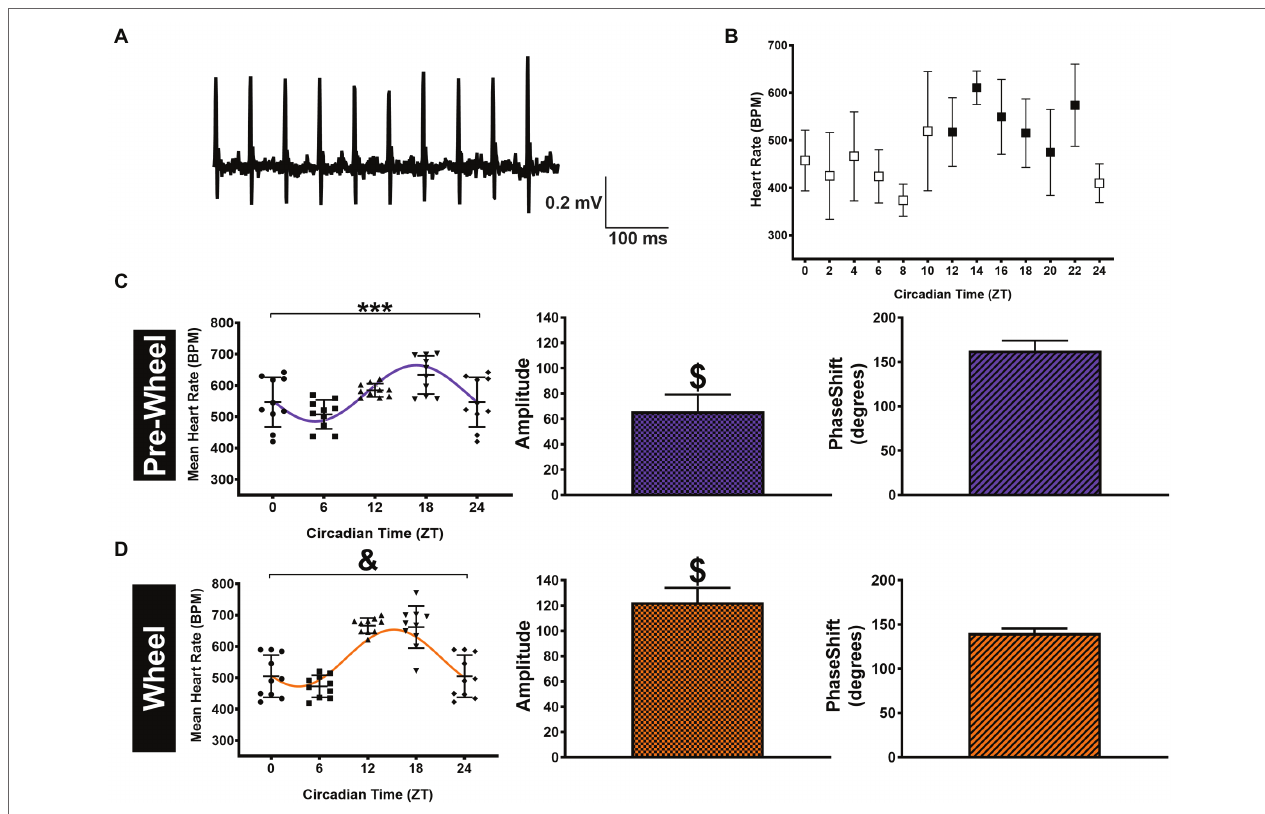
FIGURE 2 | HR measurements and analyses in telemetrized conscious mice. (A) Representative sample telemetry ECG tracings recorded from a sedentary mouse at ZT 12. (B) HR data ( n = 5 mice) displayed in 2-h intervals with the mean HR determined by averaging the HRs estimated for 1 h before and 1 h after the time point shown (open symbols = light phase and filled symbols = dark phase). (C) HR data for conscious (pre-wheel) mice at ZT 0, ZT 6, ZT 12, and ZT 18 (ZT0 = ZT24) (left panel) . The line shows the curve predicted by nonlinear sine function fits to the HR data with amplitude (middle) and phase (right) estimated from the nonlinear fits shown as Mean ± SD. (D) The same data as in (C) but for conscious mice after having access to running wheels for 1 week. *** p < 0.001 and & p < 0.0001 using a mixed-model repeated measure (left panel) . $ p < 0.0001 based on the zero amplitude (no rhythm) test from nonlinear fits (middle panel)